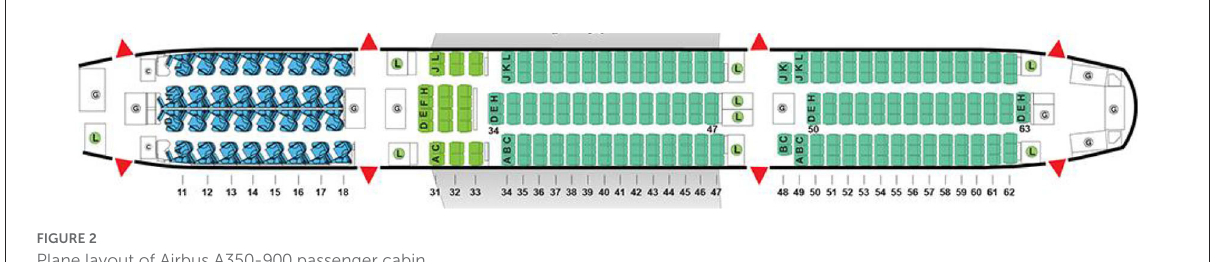
FIGURE2 Plane layout of Airbus A350-900 passenger cabin.